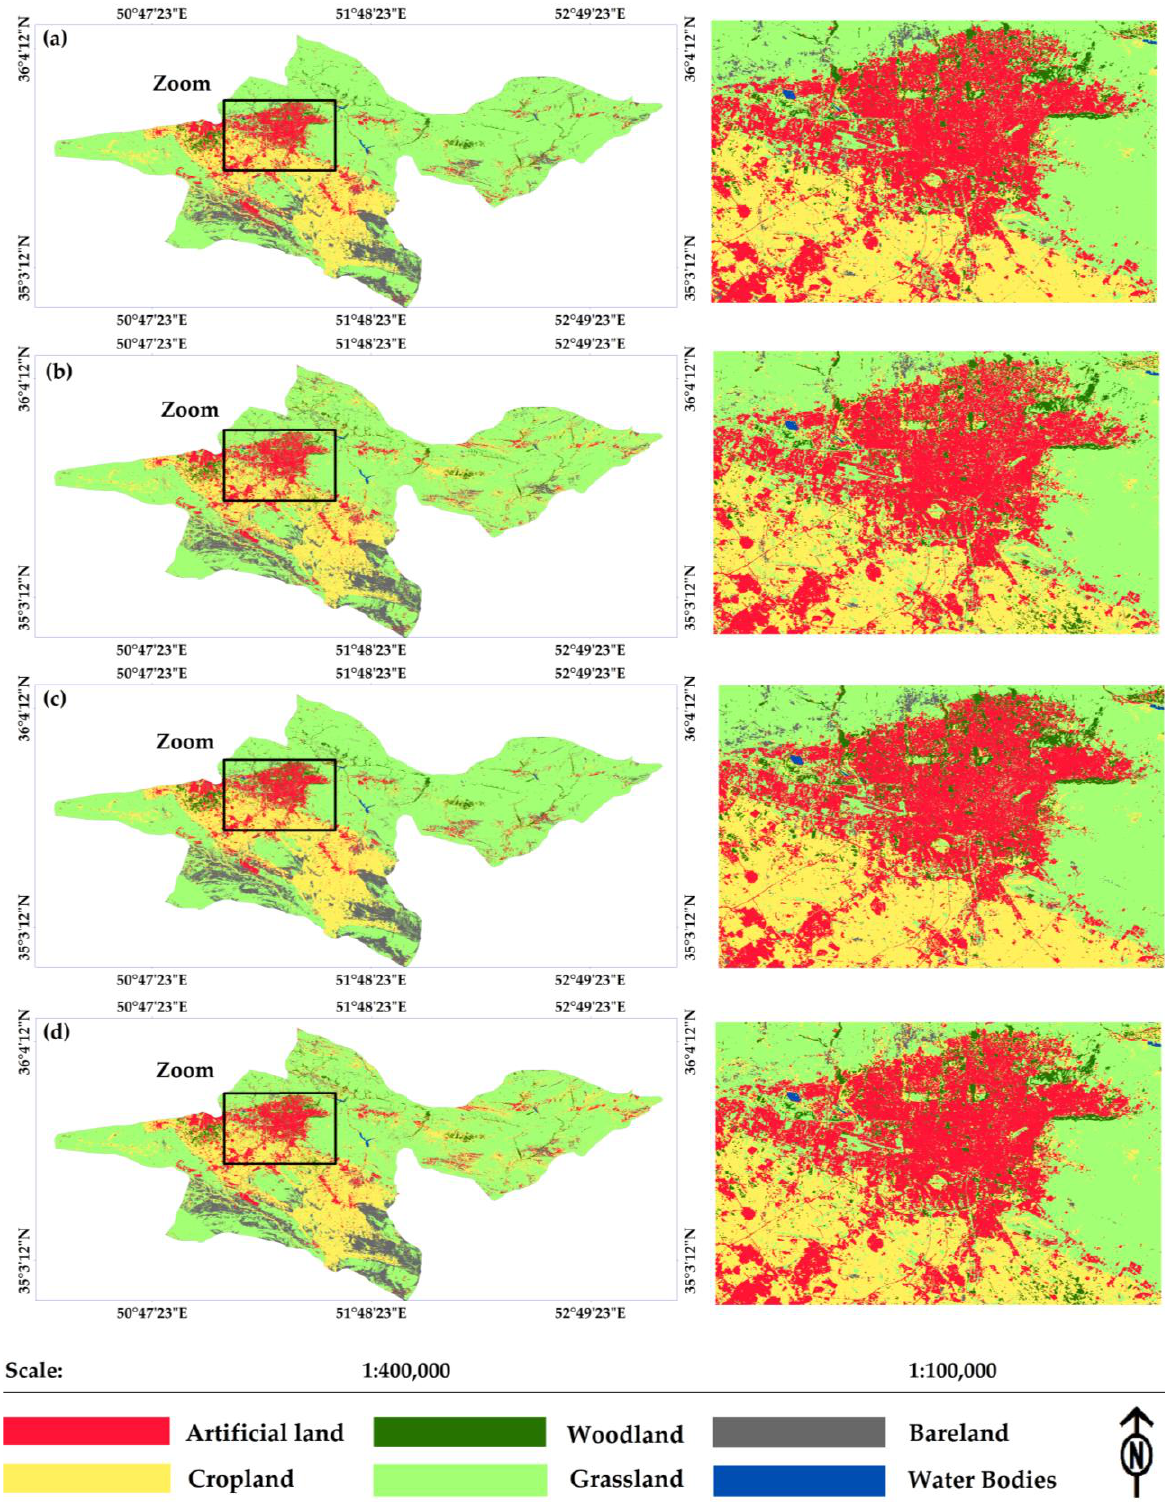
Figure 3. Land use/land cover (LULC) maps of the study area resulting from: ( a ) S-2 seasonal composites, ( b ) L-8 seasonal composites, ( c ) S-2 percentile metrics, and ( d ) L-8 percentile metrics.